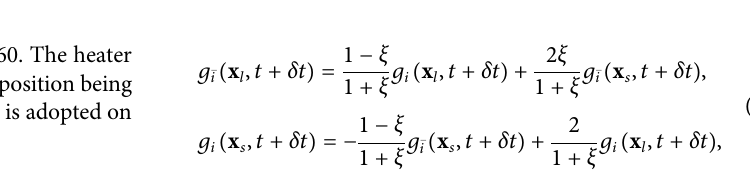
Frontiers in Energy Research |